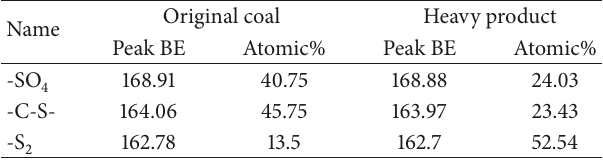
Table 4: Content of sulfur in different chemical states.